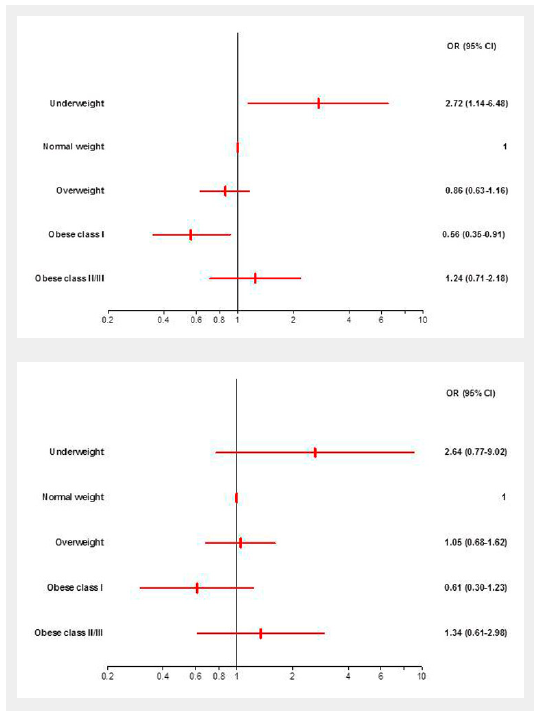
a: Unadjusted odds ratios with 95% CI for in-hospital mortality by BMI categories with normal weight patients as the reference. The odds for in-hospital mortality were significantly higher for underweight and significantly lower for obese class I patients. OR, Odds Ratio. CI, Confidence Interval. b: Adjusted odds ratios with 95% CI for in-hospital mortality by BMI categories with normal weight patients as the reference. None of the BMI groups differed significantly in the odds for in-hospital mortality compared with normal weight patients. OR, Odds Ratio. CI, Confidence